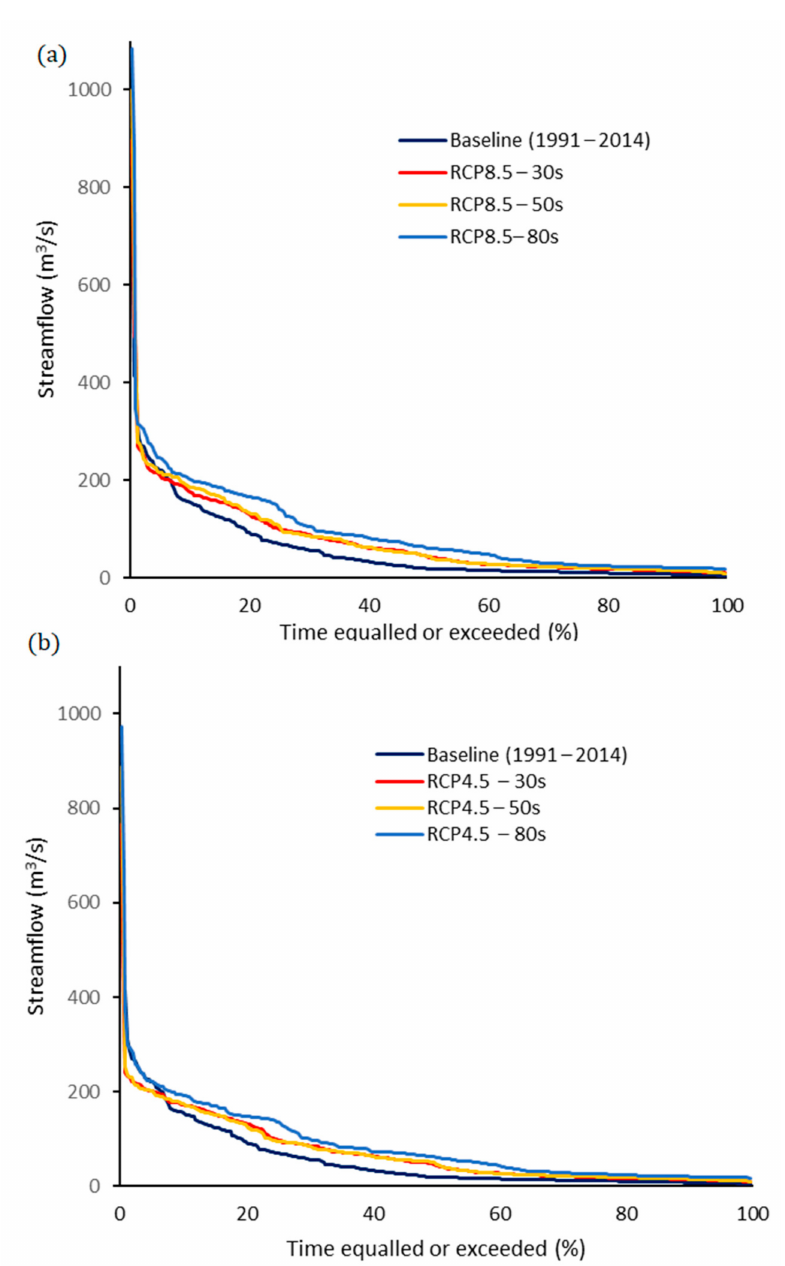
Figure 7. Flow duration curve under ( a ) RCP 4.5 and ( b ) RCP 8.5 scenarios at the Chepang